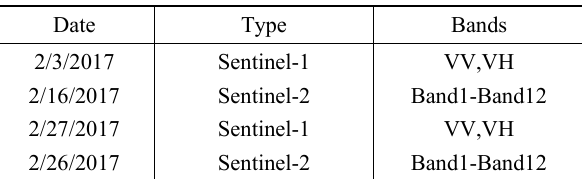
Table 1 . Pre-disaster and post-disaster data for flood in Peru,